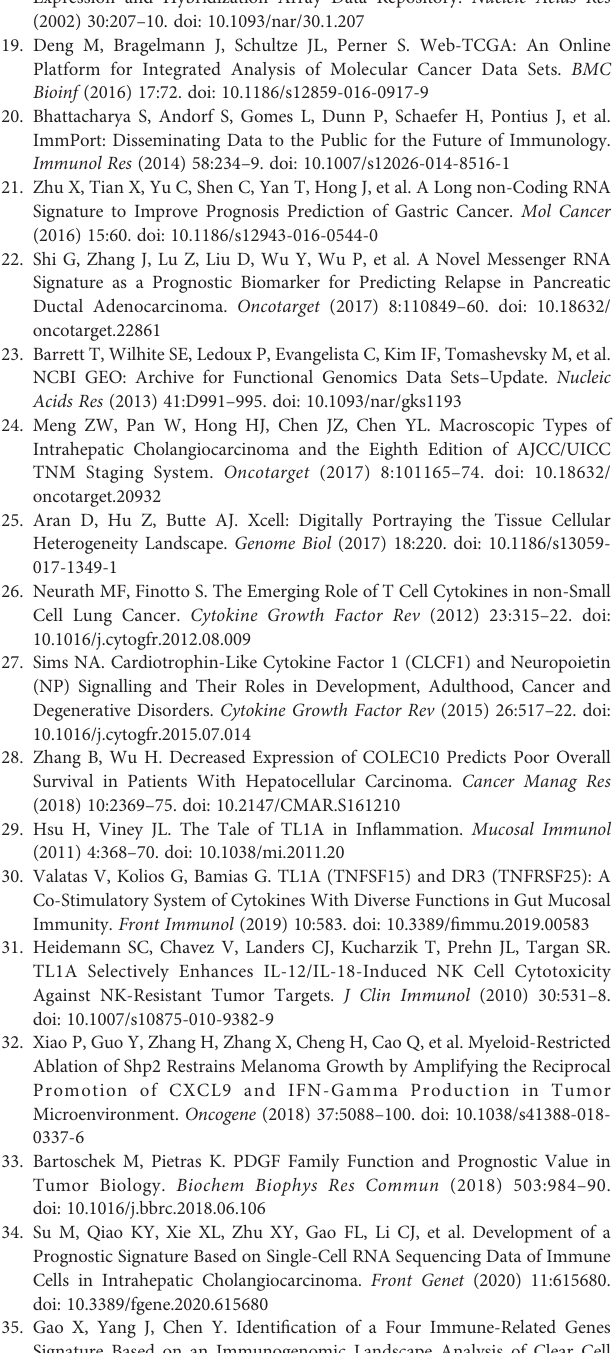
Supplementary Figure 11 | Kaplan-Meier survival analyses of the Ren Ji cohort, according to the 8-IRDEGs -based classi fi er strati fi ed by clinicopathological characteristics. (A, B) Gender, (C, D) Age, (E,F) Tumor size, (G,H) Lymph node metastasis, (I,J) Modular, (K, L) CA 19-9 level, (M,N) Distant metastasis, (O,P) Tumor thrombus, (Q,R) Stage. (P-values were calculated using the log-rank test. HR, hazard